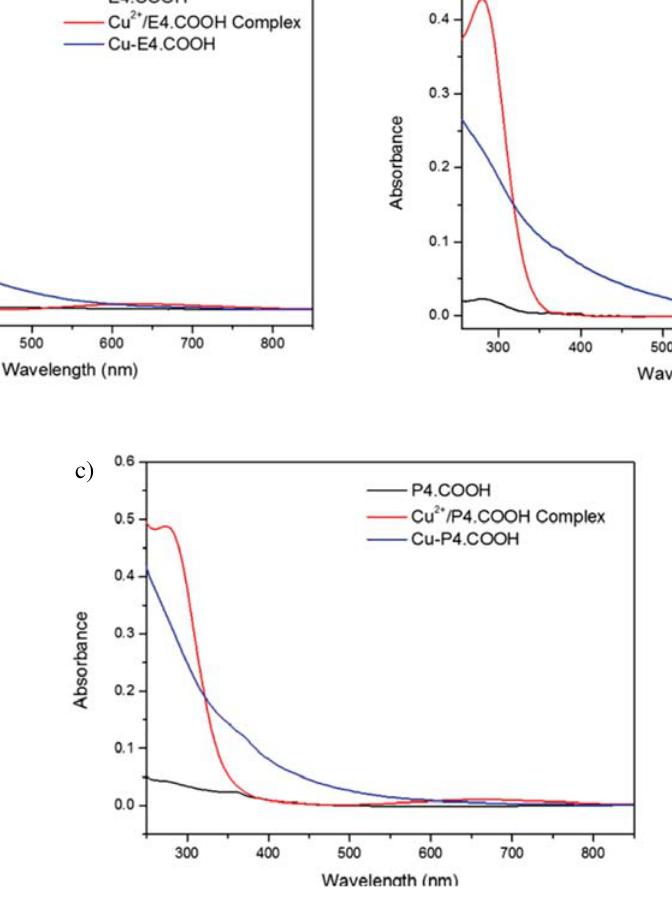
Figure 7. UV-Vis absorption spectra of the formation of (a) Cu-E4.COOH; (b) Cu-D4.COOH, and (c) Cu-P4.COOH.